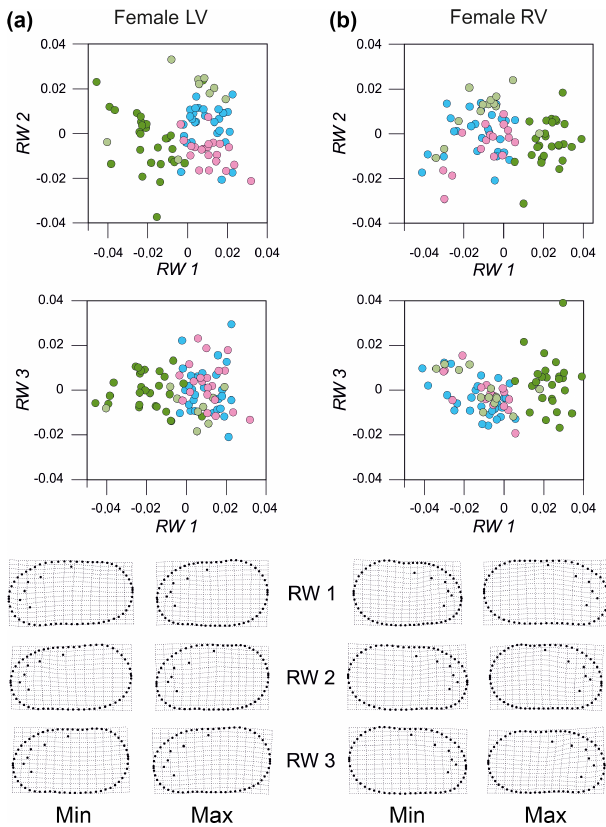
Figure 2. Relative warp analyses of left (a) and right (b) valves of females of the first three warps and the associated thin-plate splines at minimum and maximum scores. Colours refer to the different regions (blue – Florida, green – Mexico, light green – Lake Punta Laguna, pink –